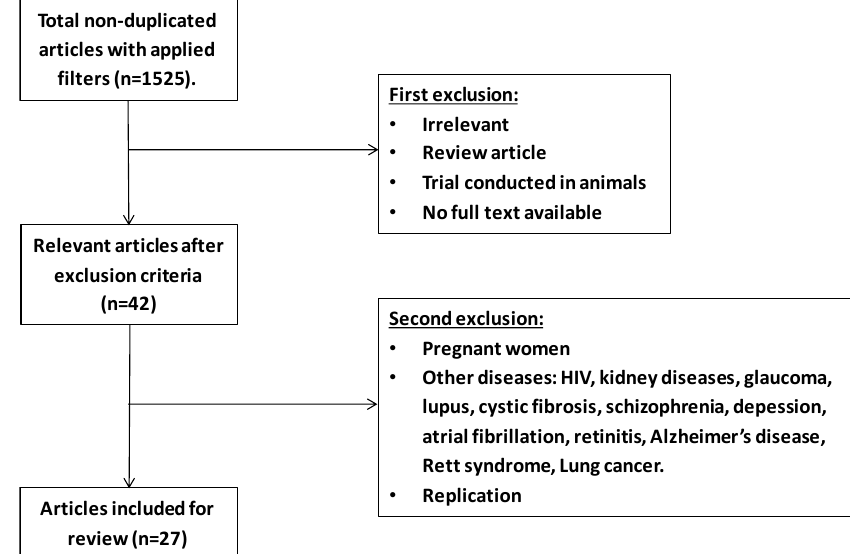
Figure 2. Flowchart of selection process based on n-3 PUFA and oxidative stress.